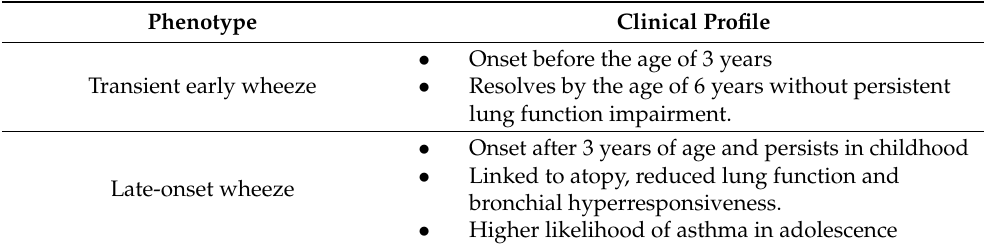
Table 3. Wheezing child phenotypes. IgE, immunoglobin E; NA, not available. Elaborated from data in